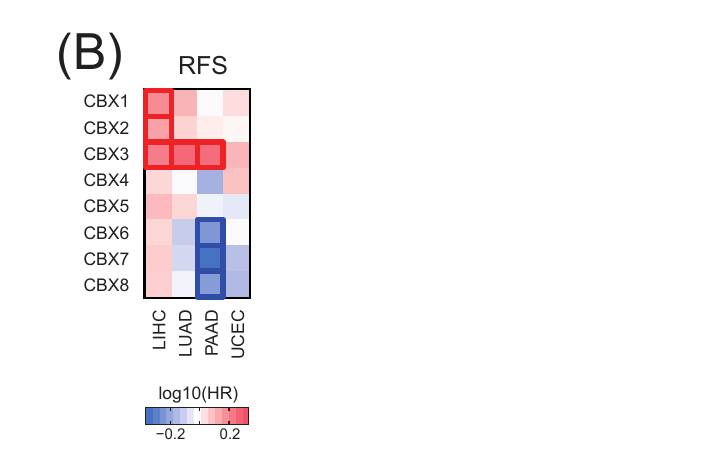
Figure 2. The association between CBX family members and patient prognosis in selected TCGA tumors. The heatmap of the hazard ratio of death ( A ) or relapse ( B ) for patients with high expression of specific CBX family members (with the mean expression as a cut-off). Red and blue denote higher or lower hazard ratios, respectively. Bordered squares denote statistically significant HRs ( p < 0.05).